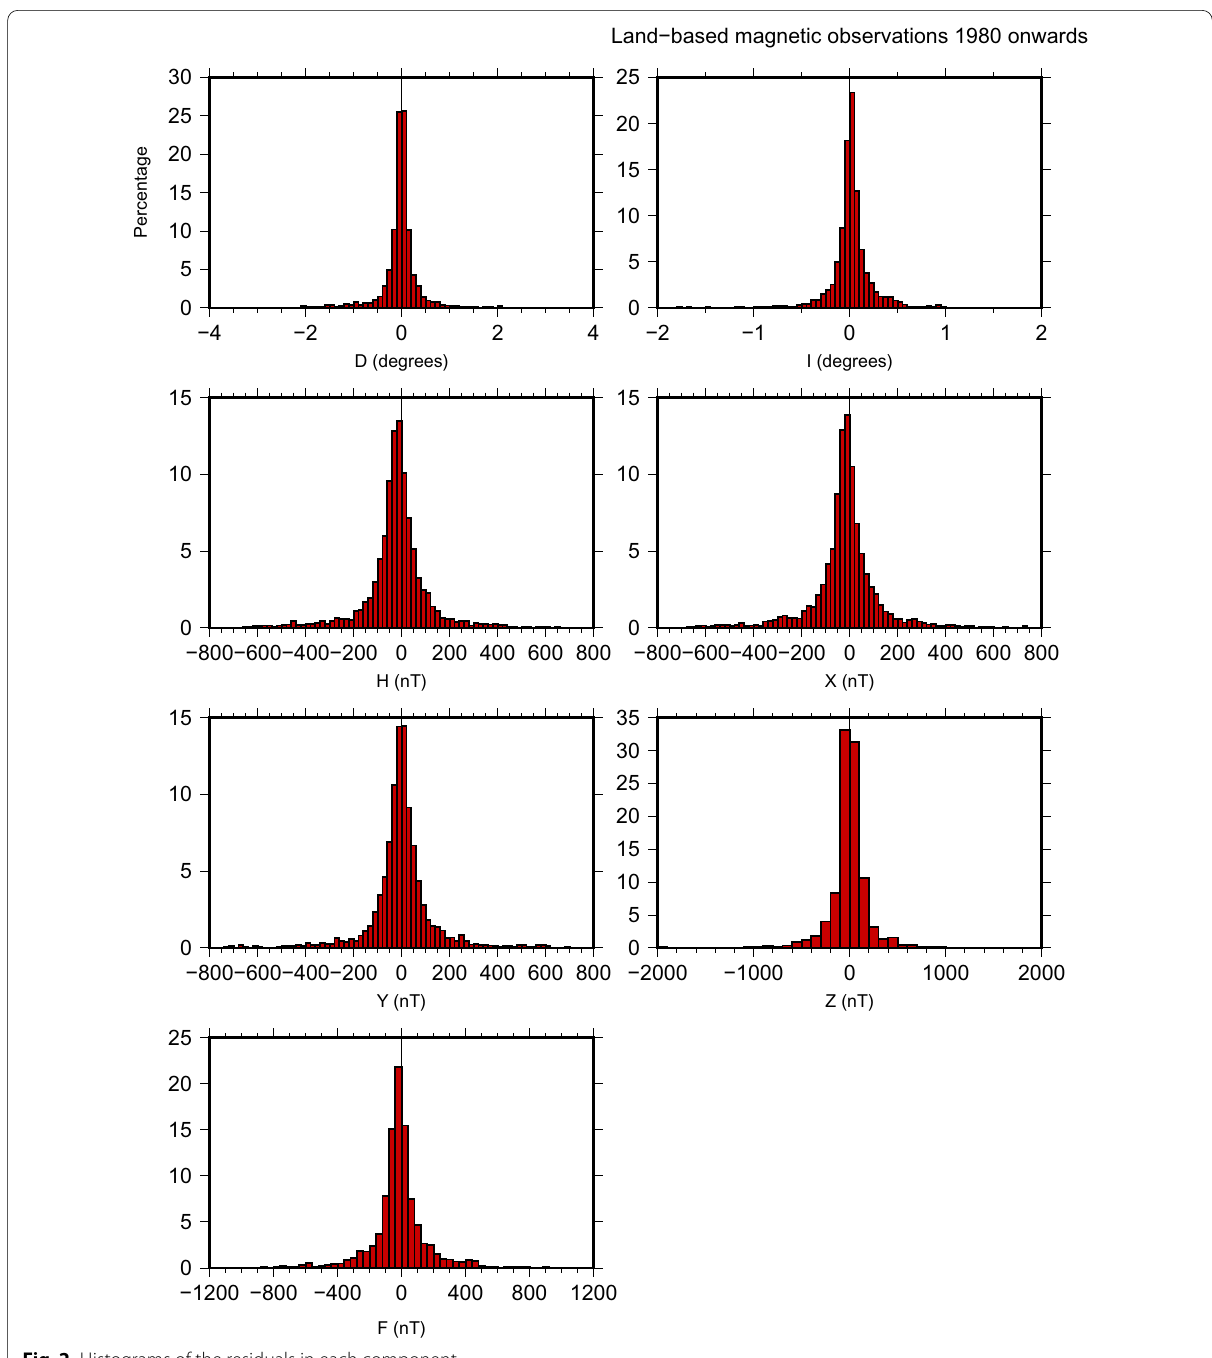
Fig. 2 Histograms of the residuals in each